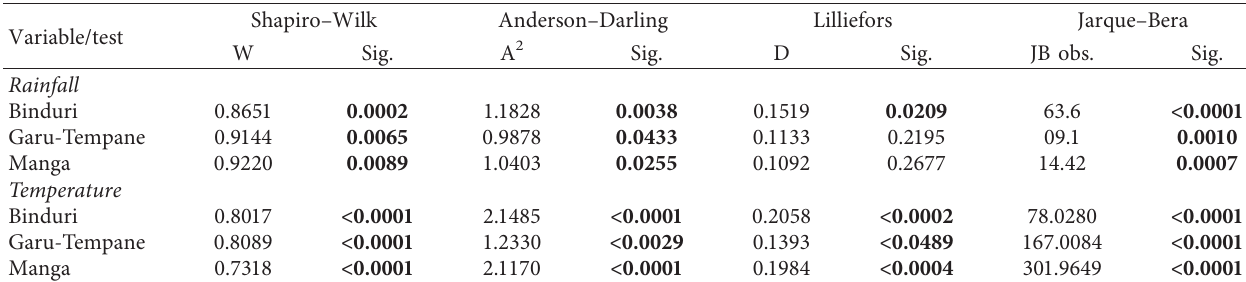
Table 3: Normality test of temperature and rainfall